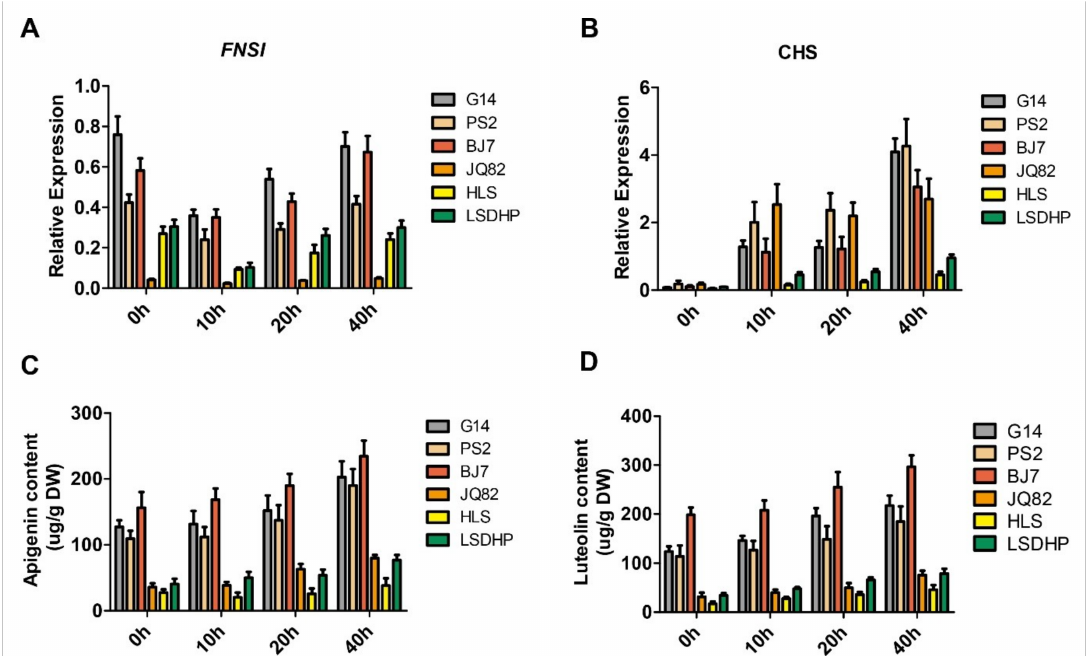
Figure 4. Regulation of MnFNSI expression and flavones accumulation by UV-B radiation. ( A , B ) Expression analysis of mulberry FNSI and CHS by qRT-PCR after the UV-B radiation treatment. ( C , D ) Variability of flavone contents following UV-B radiation. 0, 10, 20, and 40 h represents 0, 10, 20, and 40 h after the UV-B treatment,